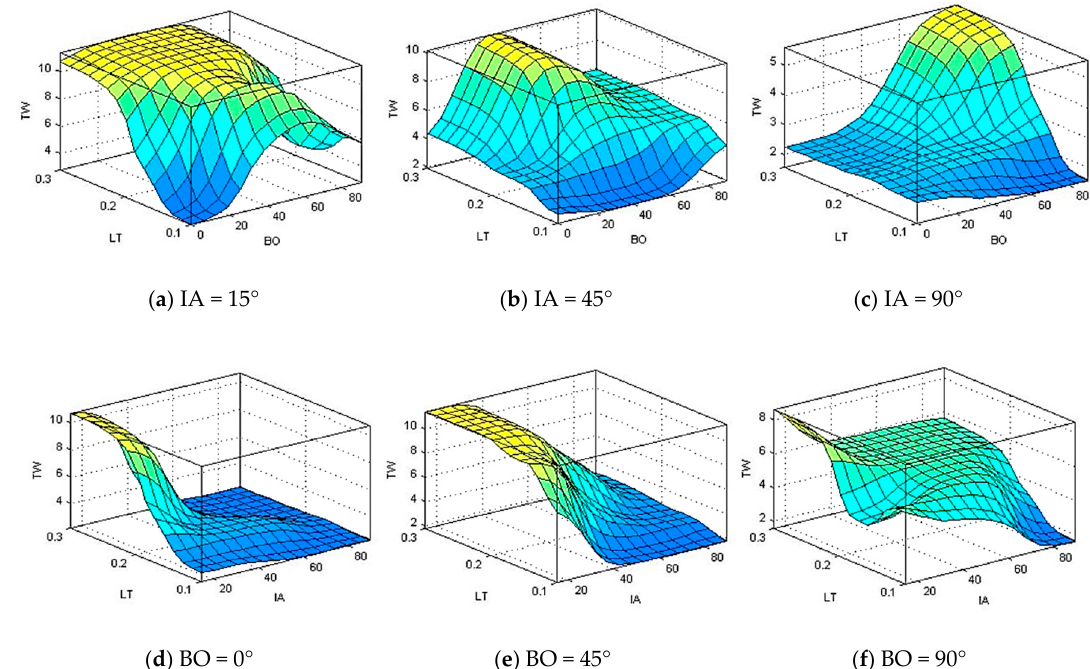
Figure 13. Total weight gain (TW) in relation to change of building orientation (BO) and layer thickness (LT), and impact angle (IA) at ( a ) IA = 15°, ( b ) IA = 45°, ( c ) IA = 90°, ( d ) BO = 0°, ( e ) BO = 45°, and ( f ) BO = 90°.